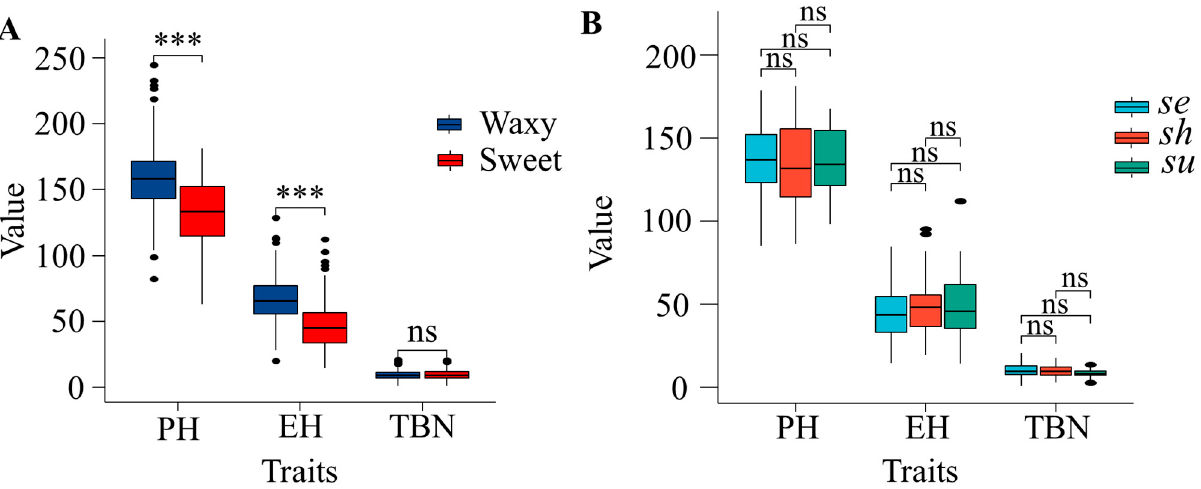
**correlation is significant at p < 0.01. Figure 1. Distribution of phenotypes for PH, EH, and TBN in maize. ( A ) PH. ( B ) EH. ( C ) TBN. Between sweet corn and waxy corn, significant difference was observed for PH, as well as for EH. Waxy corn had higher means of PH and EH than that sweet corn (Figure 2A). In the three subgroups of sweet corn, the three plant architecture traits did not show a significant difference (Figure 2B).